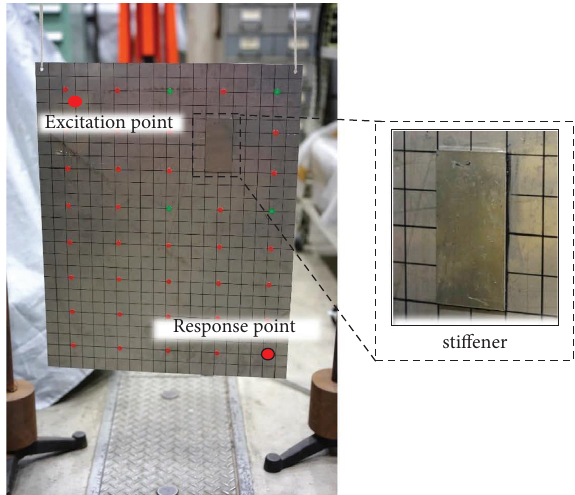
Figure 14: Plate with stifener attachment.